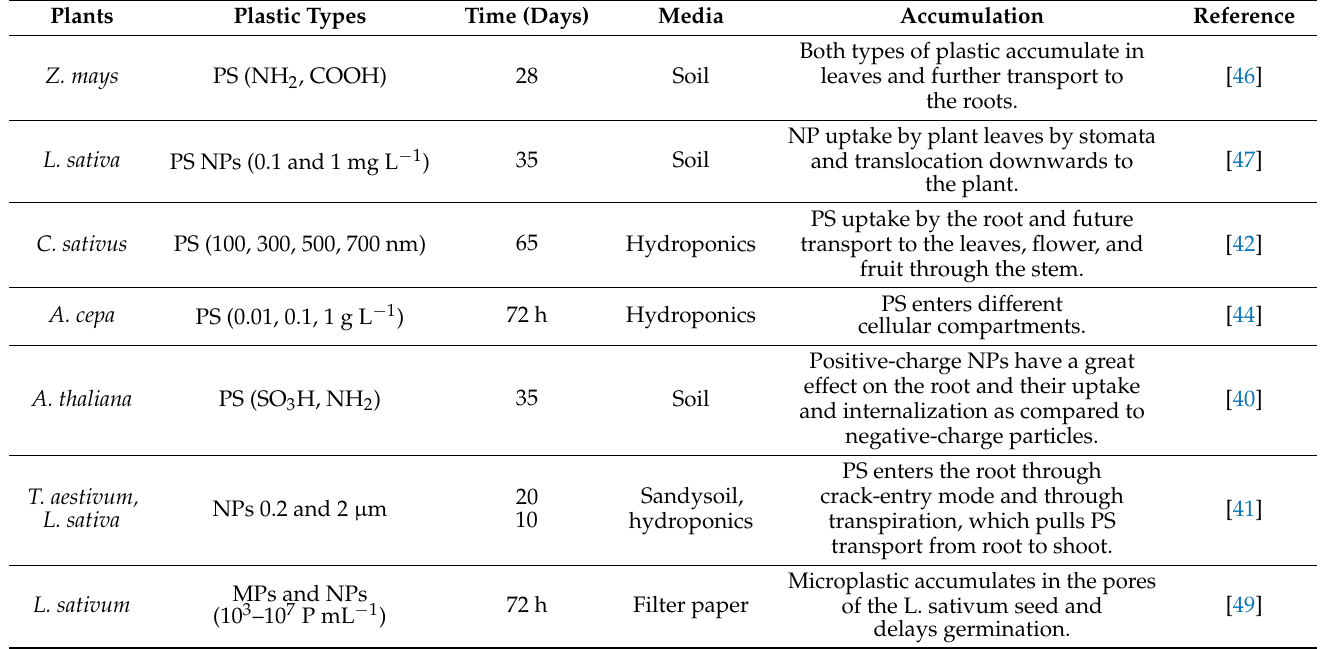
Figure 3. Plant uptake mechanism of plastic by soil application via root absorption and transport pathways from root to stem and stem transport to leaf and fruits. Foliar application reveals the entry of plastic to leaf stomata and later transfer to other parts of the plant. Cure arrow indicates the availability of plastic to plant and the dashed arrow indicates transportation within the plant. Table 2. Accumulation of plastics in plants under different exposure